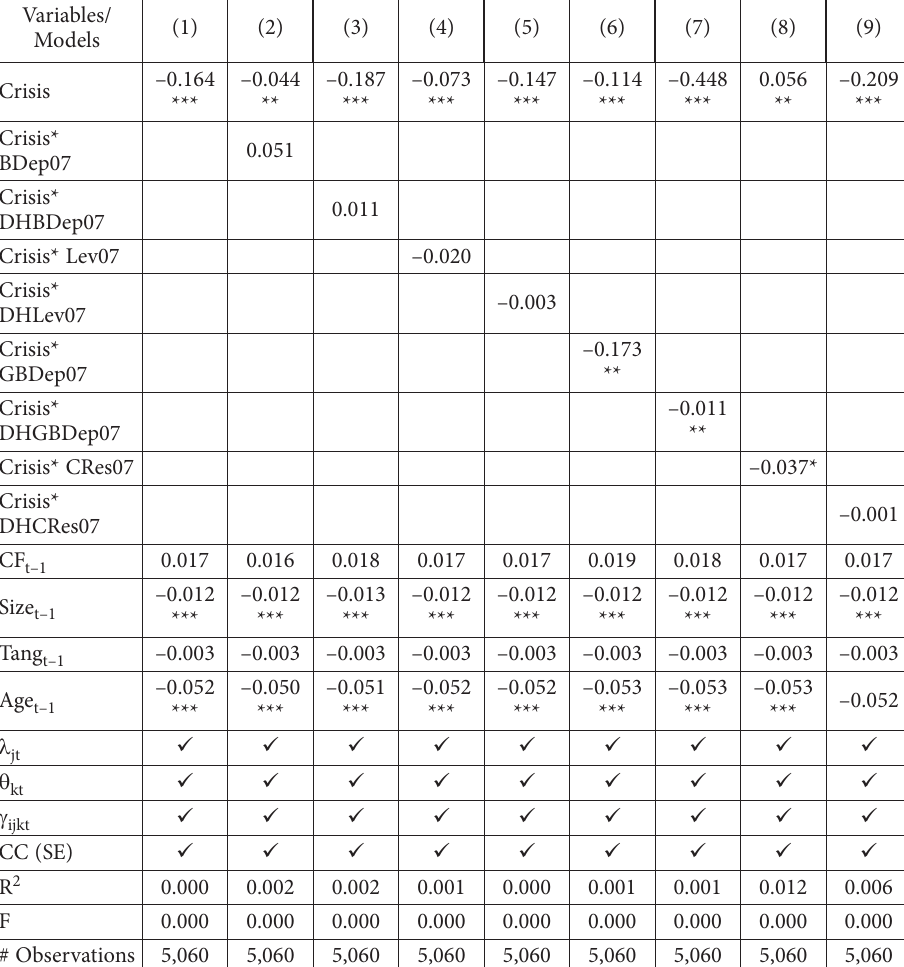
Table 5. Changes in investment in short term